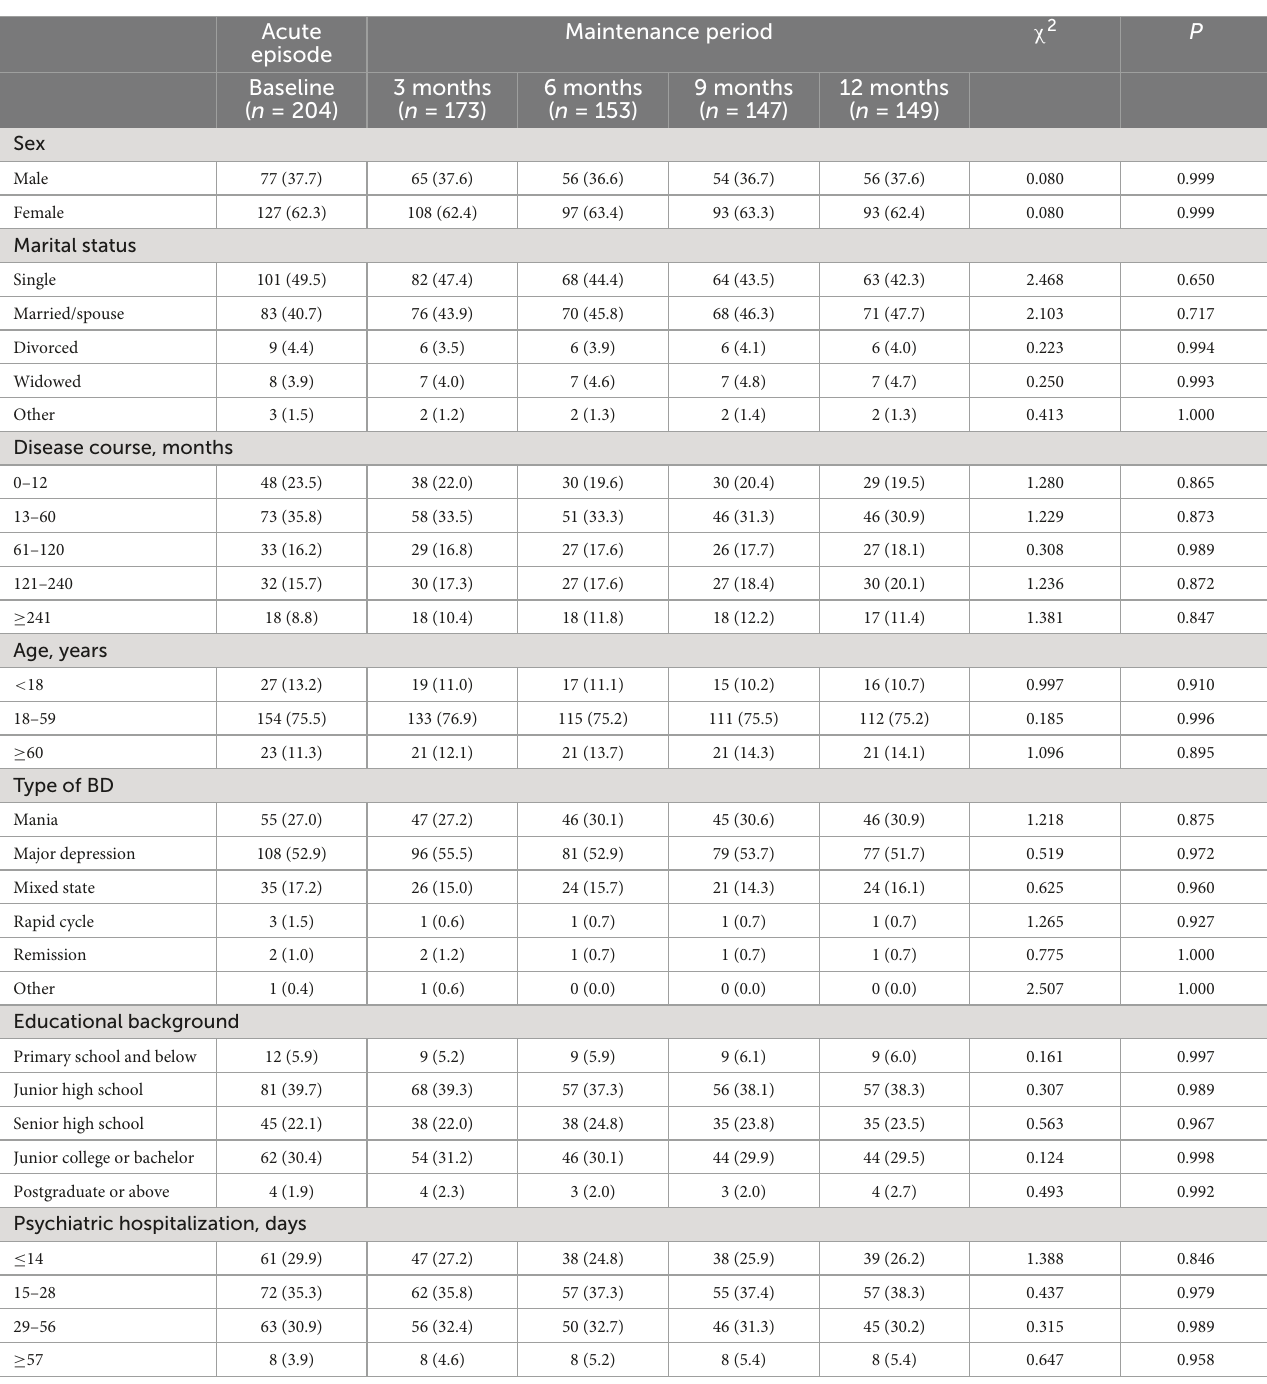
Maintenance period